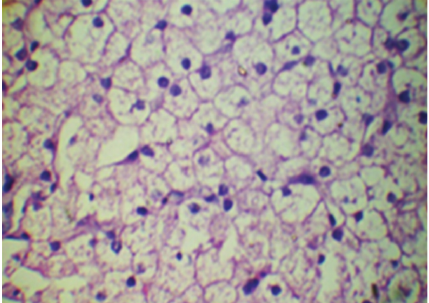
Figure 3: Showing histopathology of liver. Liver biopsy detected large pale staining hepatocytes with centrally placed nuclei giving appearance of plant cells and mosaic pattern with fibrous septa extending from portal tracts which as not entirely specific but suggestive of GSD.